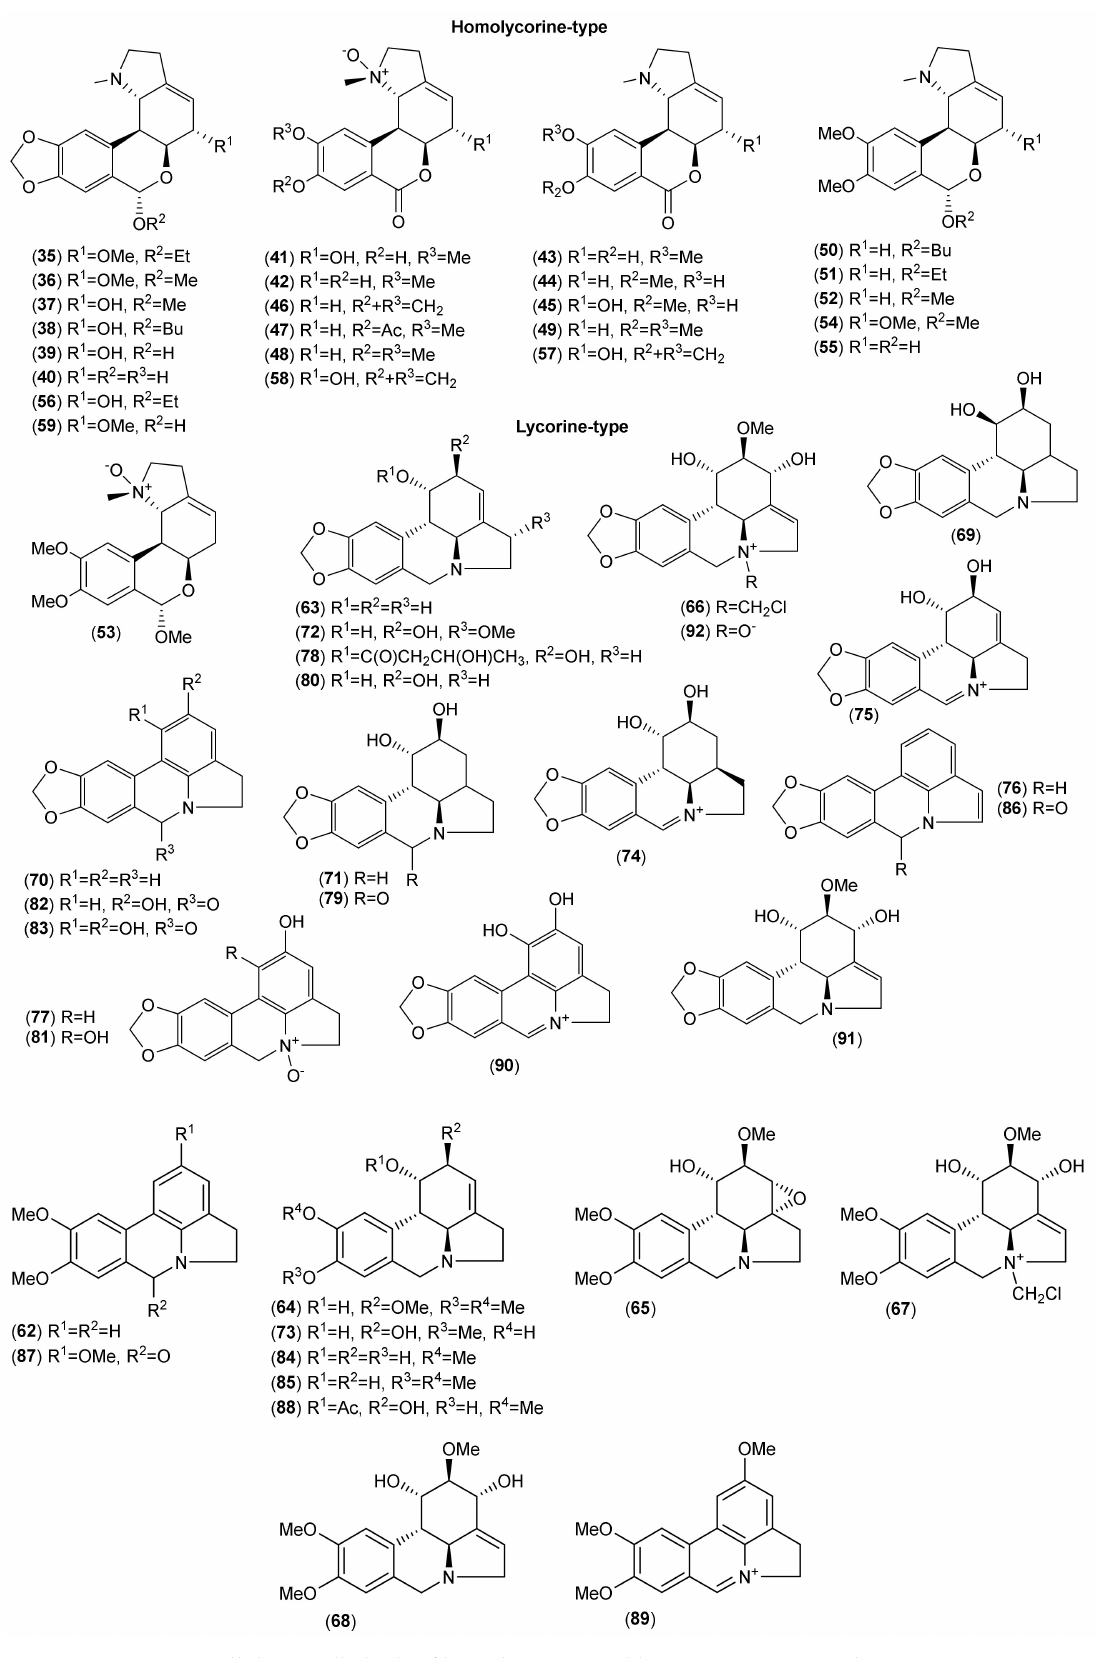
Figure 3. Amaryllidaceae alkaloids of homolycorine- and lycorine-type reported in Lycoris